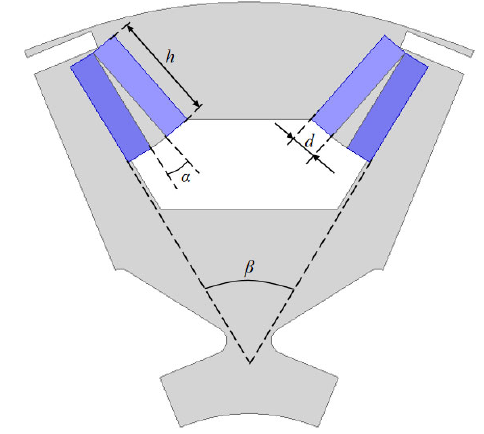
Figure 8. Optimized permanent magnet structure.